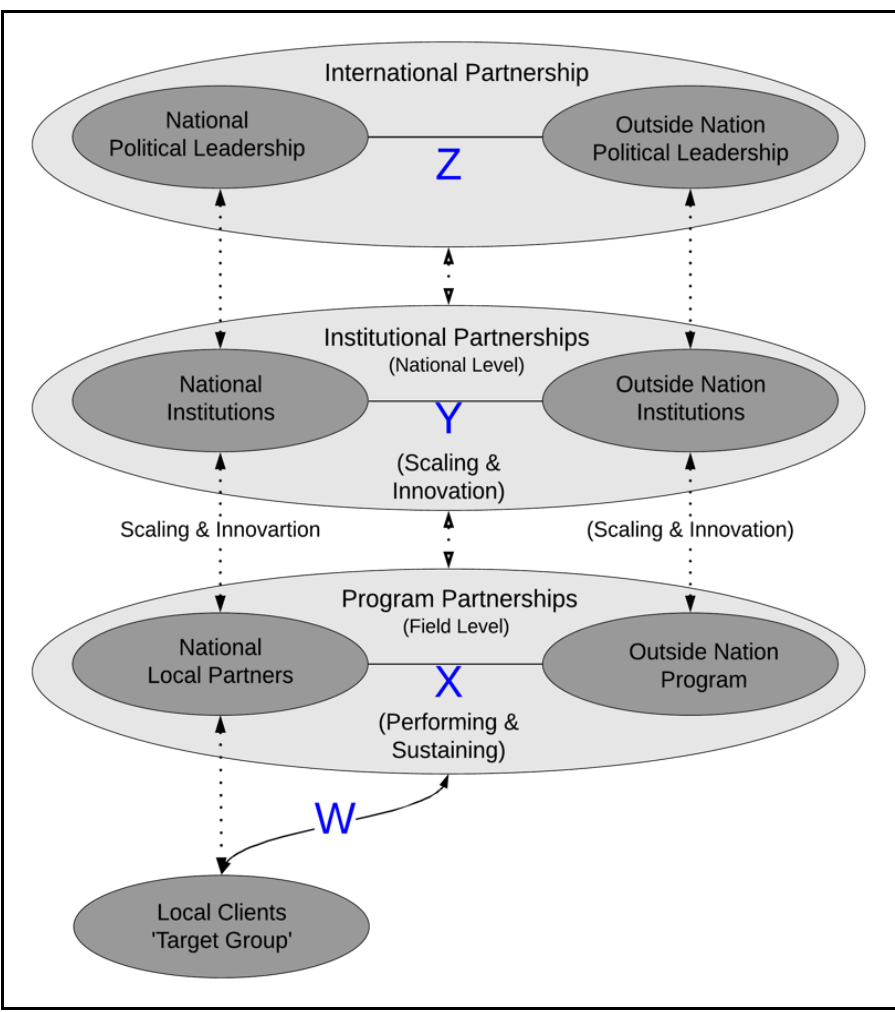
Figure 6. The Partnership Network Map.